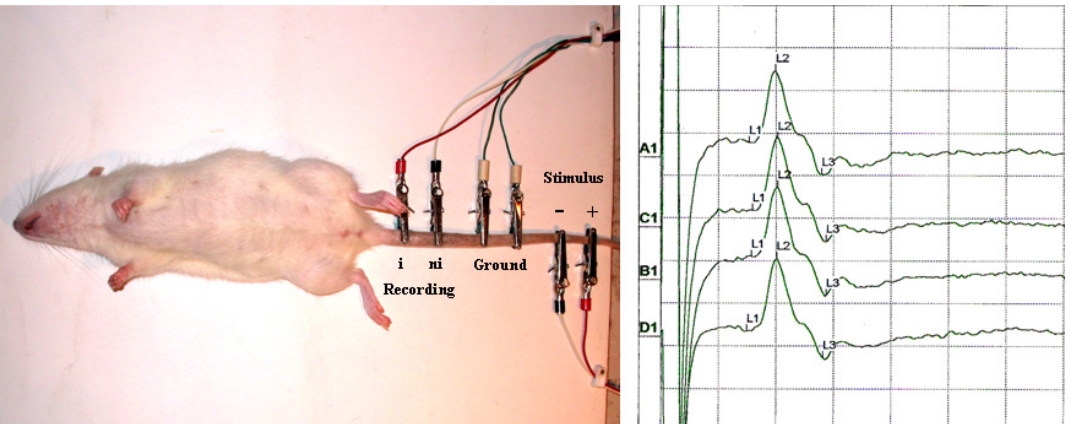
(Figure 2). The equations of linear regressions were as followed: Amplitude (µV) = 8.1 × weeks – 34 (R 2 = 0.99)